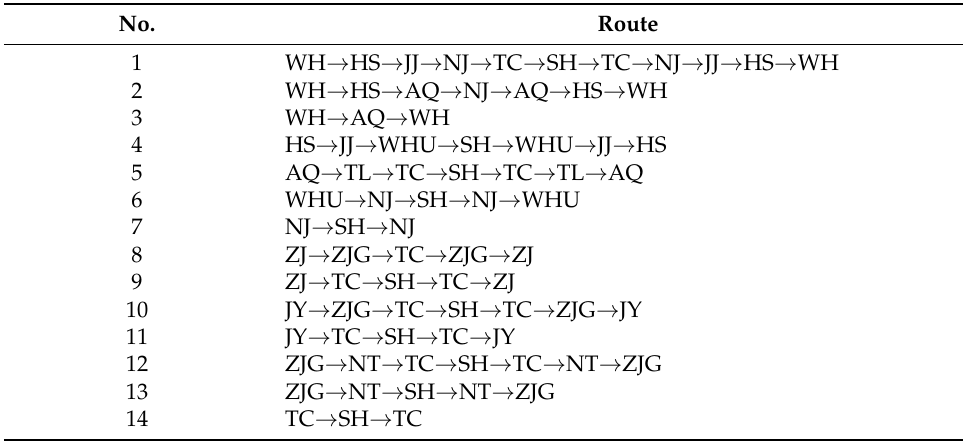
Table 4. Parameter